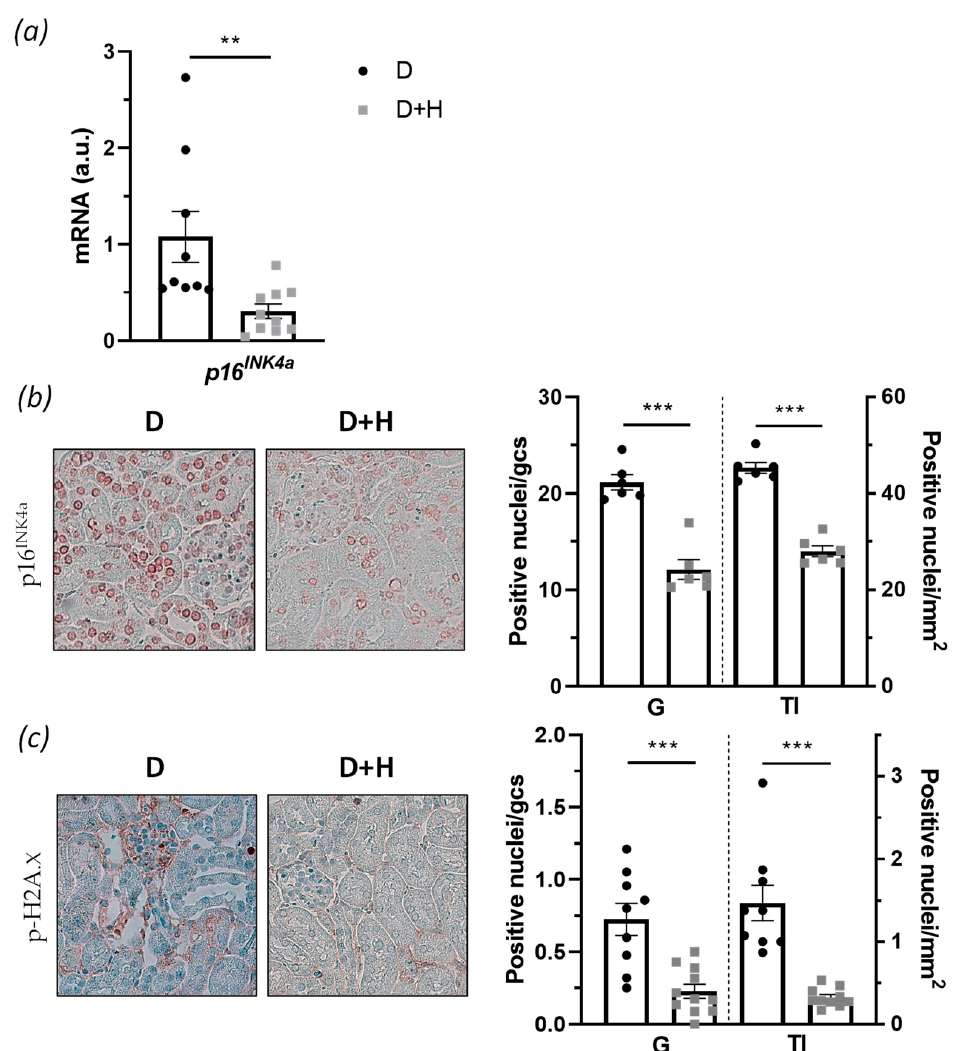
Figure 6. Hidrosmin effects on senescence markers in diabetic kidneys: ( a ) real-time PCR analysis of the cell cycle inhibitor p16 INK4a gene expression in renal samples. Values normalized to 18S gene are expressed as arbitrary units (a.u.); ( b , c ) representative images (magnification ×400) and quantification of p16 INK4a protein ( b ) and DNA damage biomarker p-H2A.X ( c ) in kidney sections from of untreated (D) and hidrosmin-treated (D + H) diabetic mice. The graphs represent individual values and the mean ± SEM of n = 9 animals (D group) and n = 11 animals (D + H group). ** p < 0.01 and *** p < 0.001 vs. D.